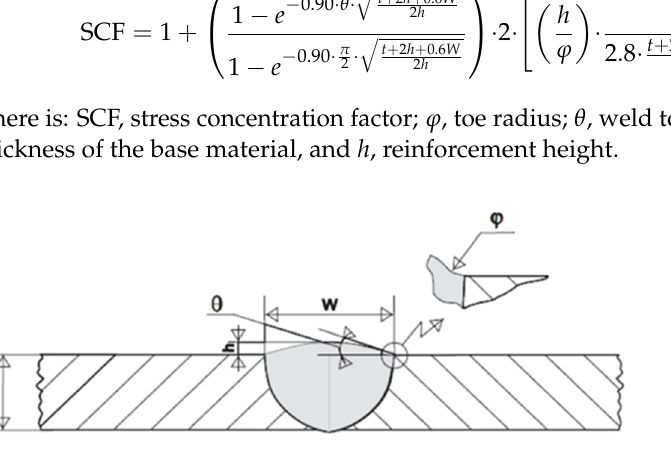
Figure 2. Influential geometric quantities of the butt-welded joint .